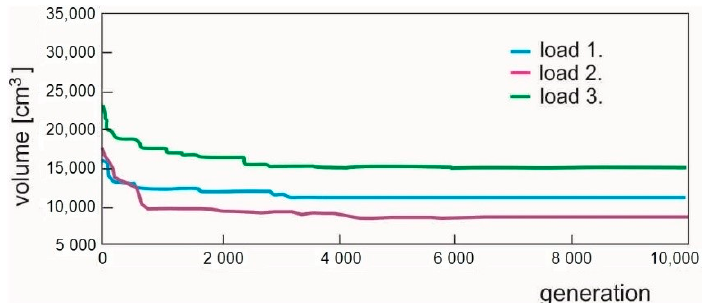
Figure 14. Changes of the volume of bars during the optimization of the initial 15 bar structure.